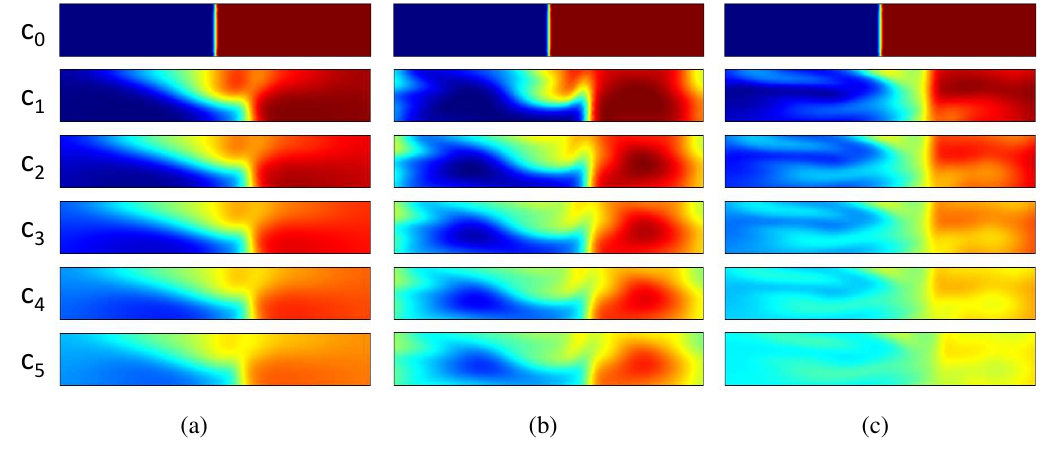
Figure 8. Evolution of the concentration in the mixer with α =1 at the three